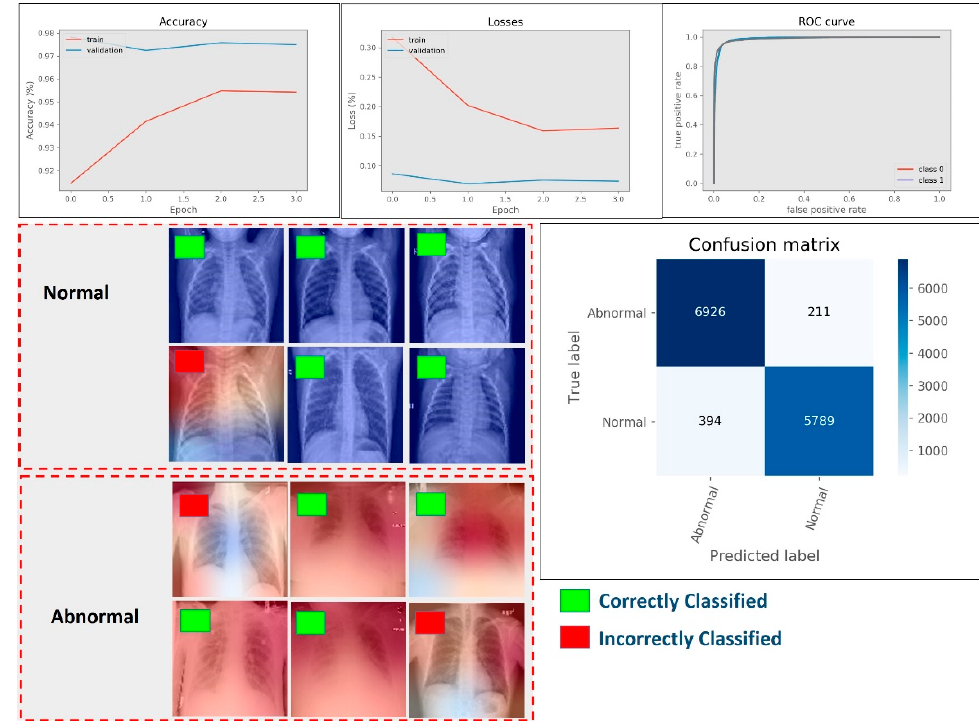
Figure 4. Visualized results for the abnormality detection. Train-validation accuracy and loss over the training epochs and AUC scores for the classes are presented in the top graph. Selected output images of the Grad-CAM implementation are visualized. Each dashed-line box presents a true class, while the green and red boxes distinguish between correctly classified samples and mistakes, re- spectively.